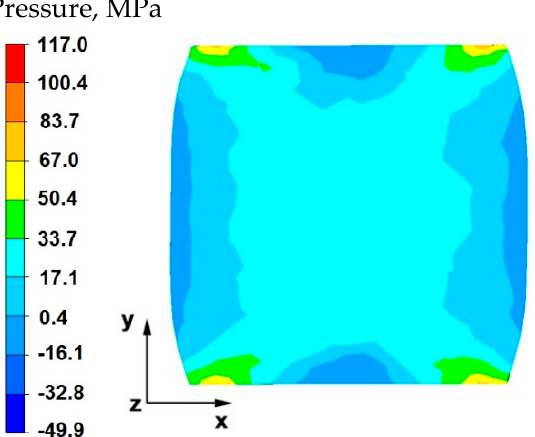
Figure 17. Distribution of hydrostatic pressure on the surface of the cross-section of the sample with modeled discontinuity after rotation by 90° and re-deformation with 35% reduction.